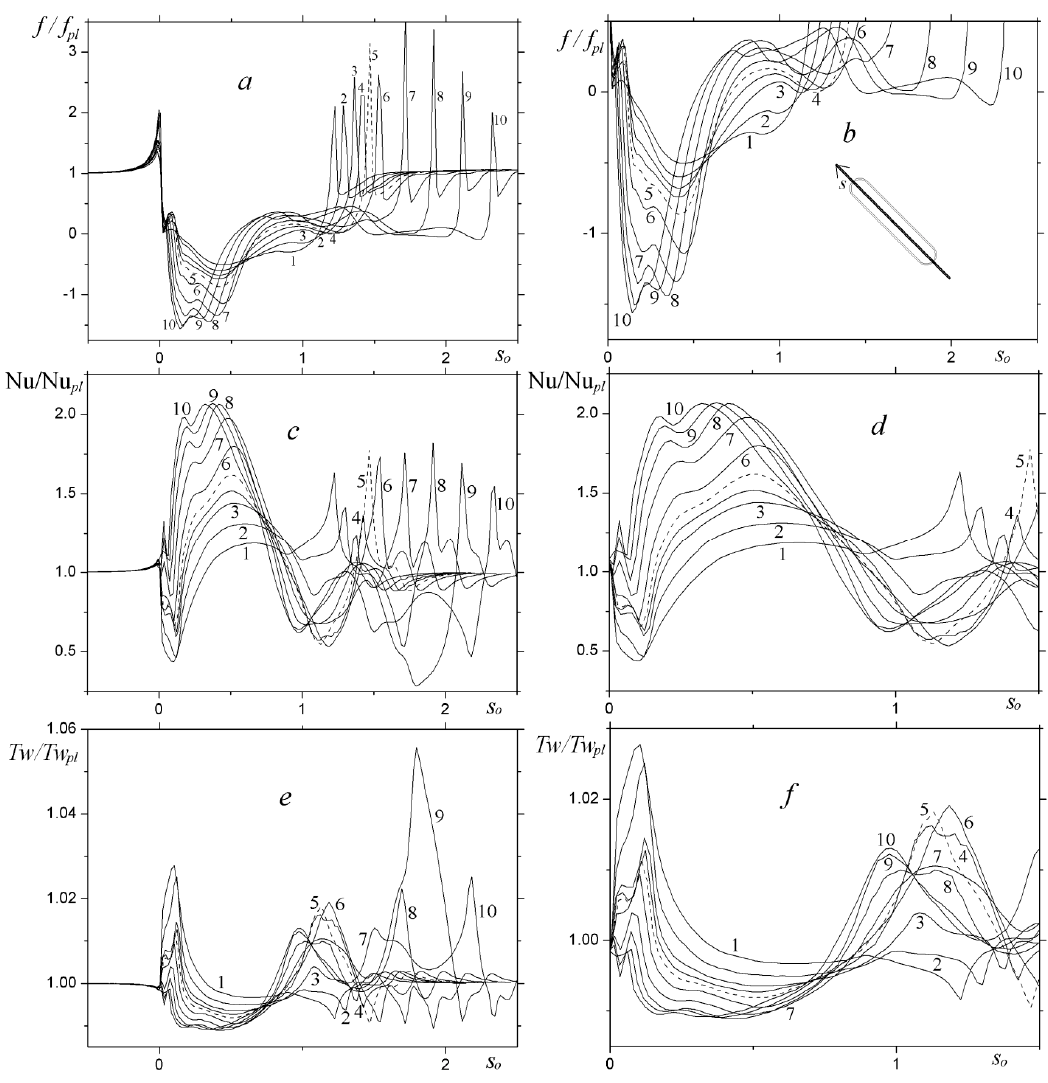
Figure 15. Comparison of the dependences of relative friction ( a, b ), Nusselt number ( c, d ), wall temperature ( e, f ) in the middle longitudinal cross sections for single oval dimples of different insert length: 1 – L = 0.5; 2 – 0.625; 3 – 0.75; 4 – 0.825; 5 – 0.9; 6 – 1; 7 – 1.25; 8 – 1.5; 9 – 1.75; 10 – 2. b, d, f – enlarged fragments of the dependences.